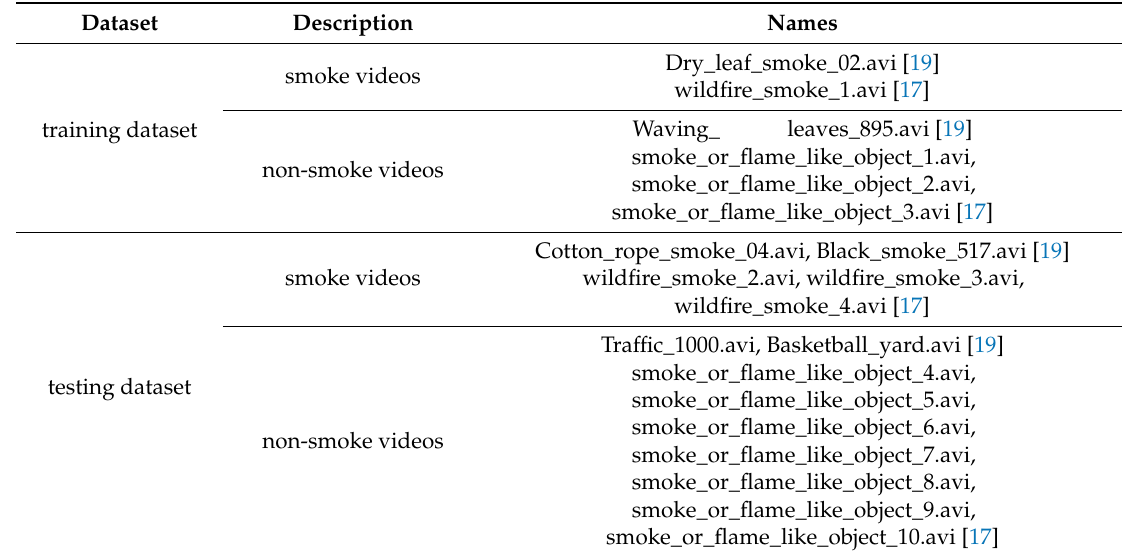
Table 2. Description of the dataset used in this